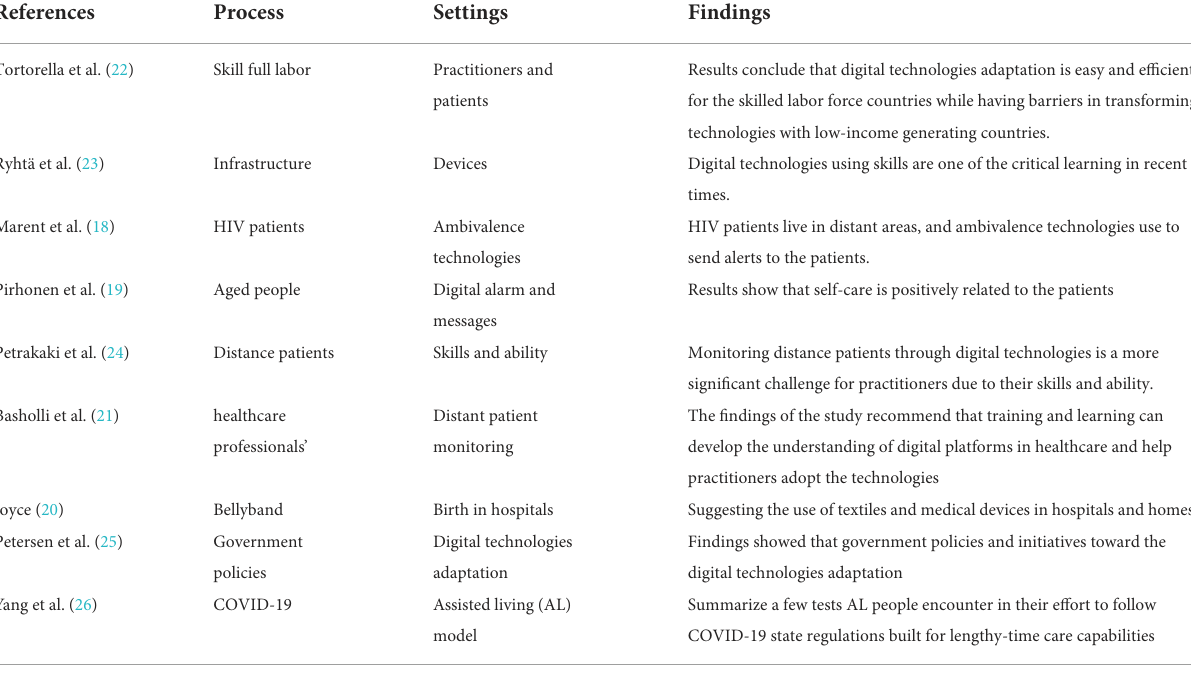
TABLE 3 Digital technologies.